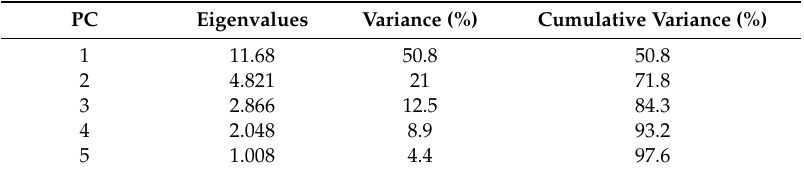
Table 4. Eigenvalues and proportion of total variability among the observed cultivars and fruit quality attributes as explained by the five principal components (PC). Peach (five cultivars) and nectarine (two cultivars) trees (500 / ha) were grown near Riesi (37 ◦ 16 (cid:48) N and 330 m a.s.l.), in central–southern Sicily.